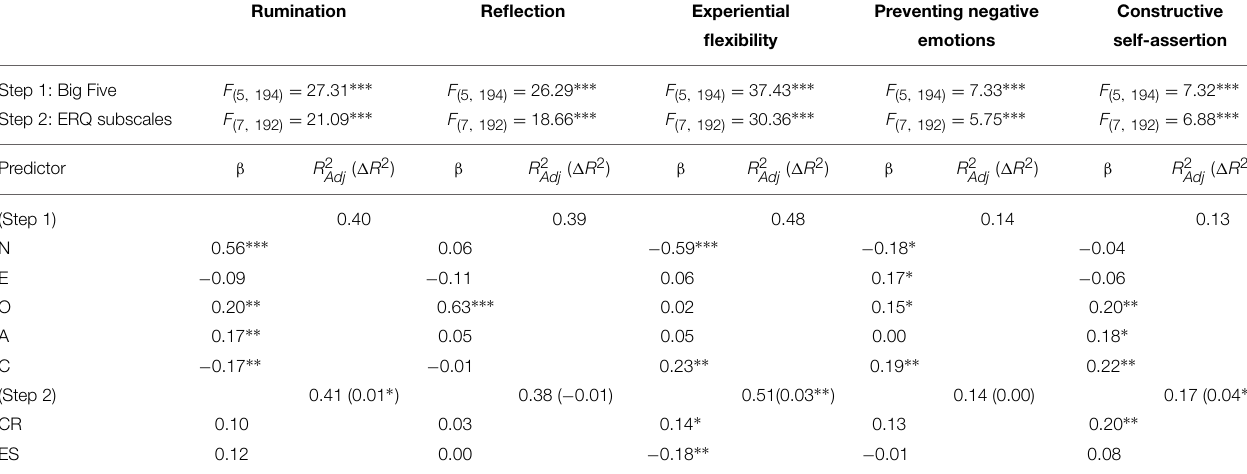
TABLE 4 | Hierarchical Regression Analyses Predicting Cognition and Mindful Coping Criteria from the Big Five (Step 1) and the two ERQ Subscales (Step 2). Rumination Reflection Experiential Preventing negative Constructive flexibility emotions